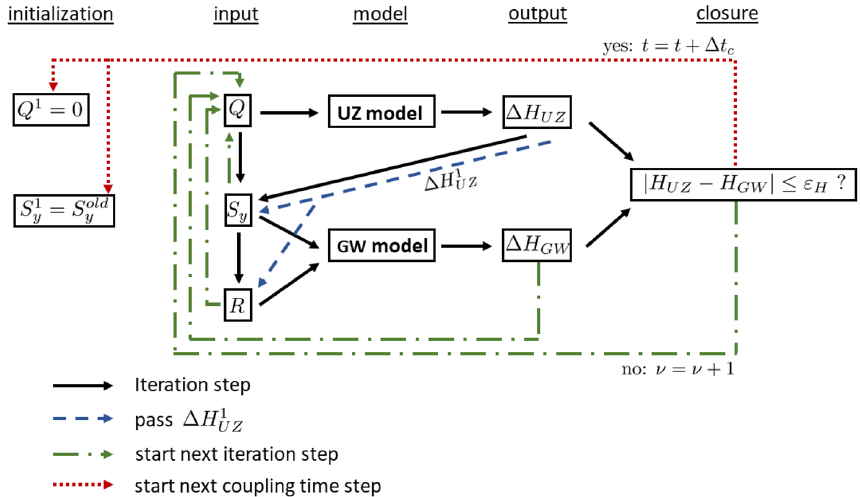
Figure 3. Flow diagram for the iterative coupling.